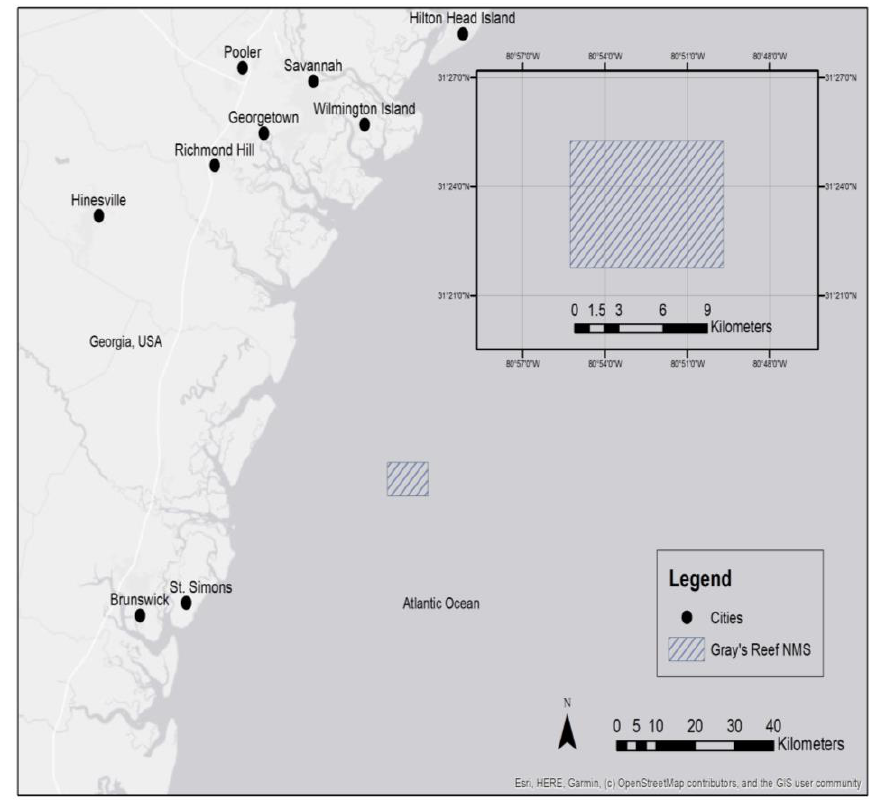
Figure 2. Study area surrounding coastal Georgia, USA with Gray ’ s Reef National Marine Sanctuary shown as the hatched box boundary approximately 19 miles (30 km) east of the USA mainland in the Atlantic Ocean. The inset map in the top right corner shows a detailed view of the Sanctuary boundary with a geographic coordinate reference.